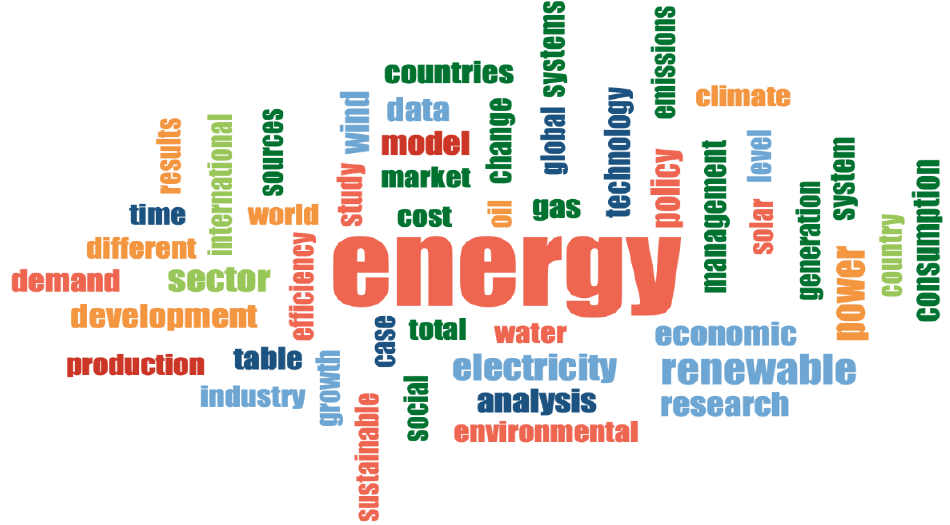
Figure 1. Word cloud (based on 77 analyzed documents). Source: own study.